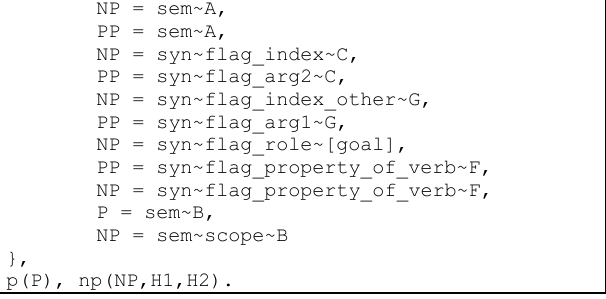
Figure 5. Analyze the Pphrase in group D based on framework GULP (Source: T. Tran and D. T. Nguyen